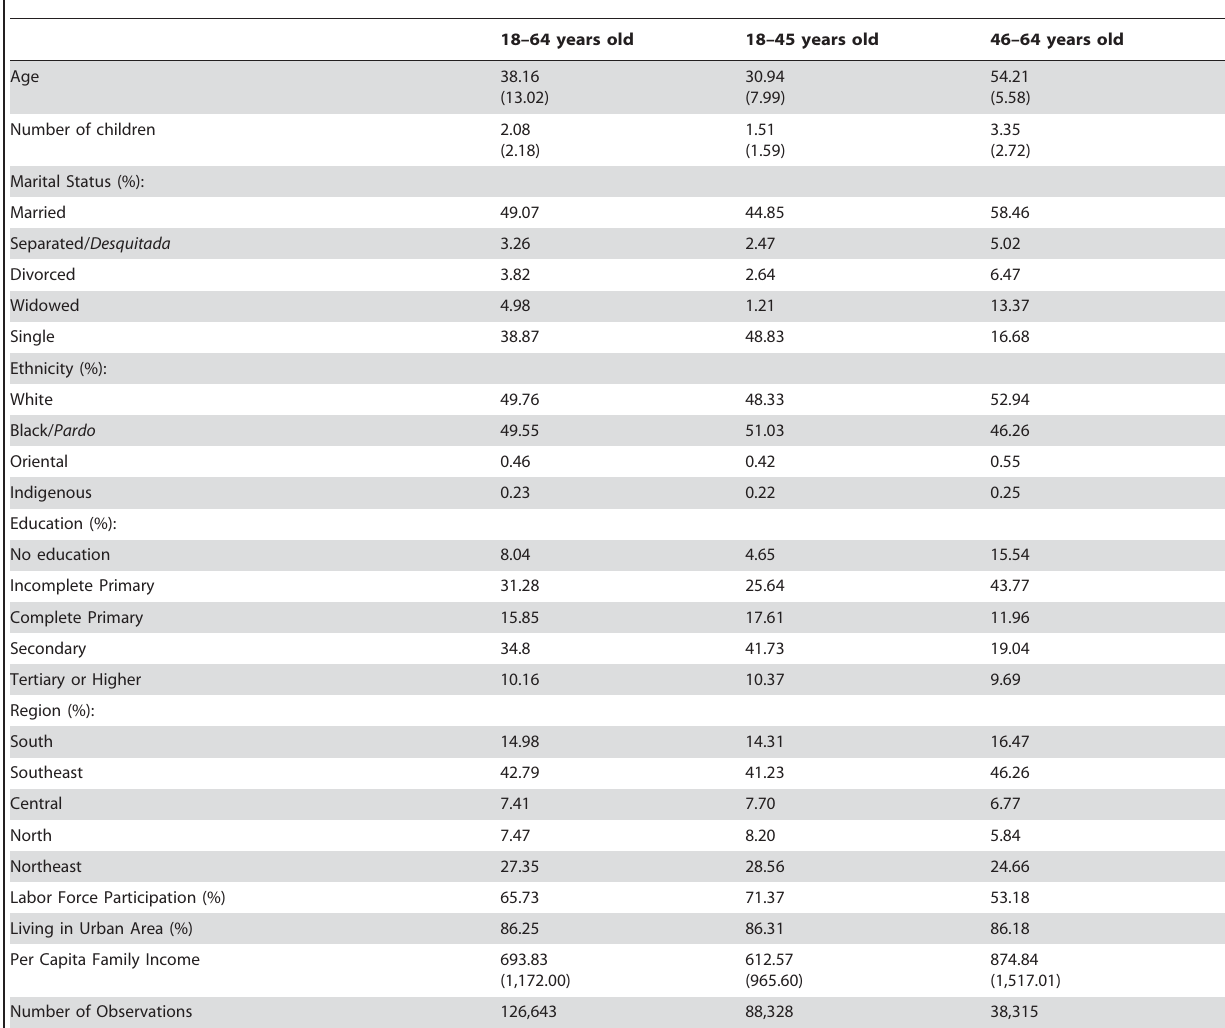
Table 1. Demographic Information Pertaining to Women in Brazil